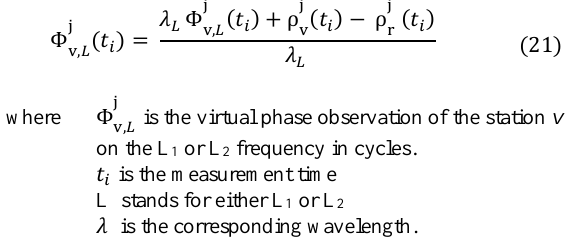
Table 1. Processing results between master and other